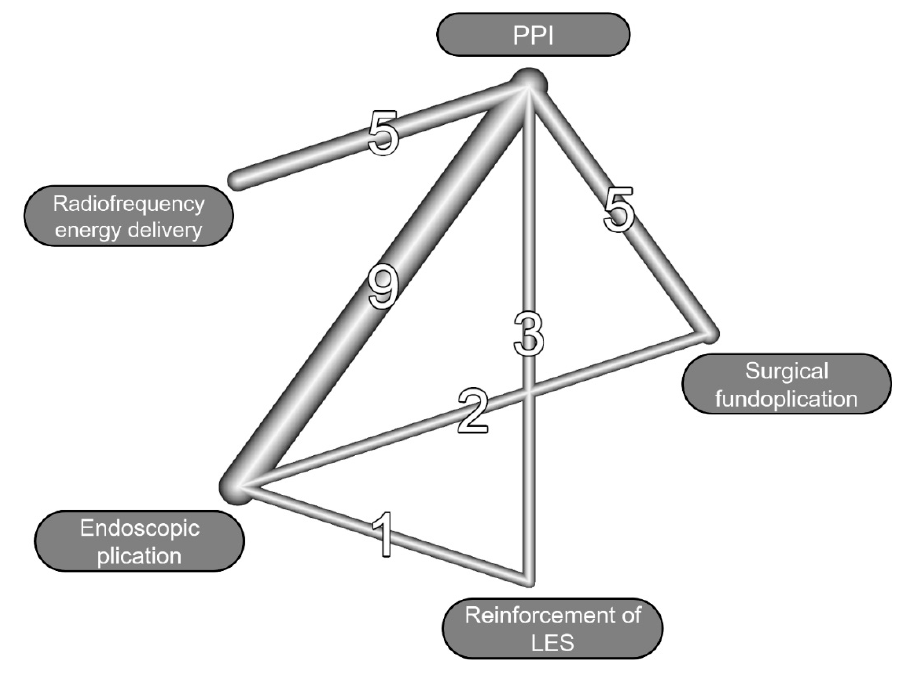
Figure 2. Evidence network of different treatments of gastroesophageal reflux disease. The line represents the comparison between different treatments. The thickness of the line and the numbers represent the number of studies included in each comparison. PPI, proton pump inhibitor; LES, lower esophageal